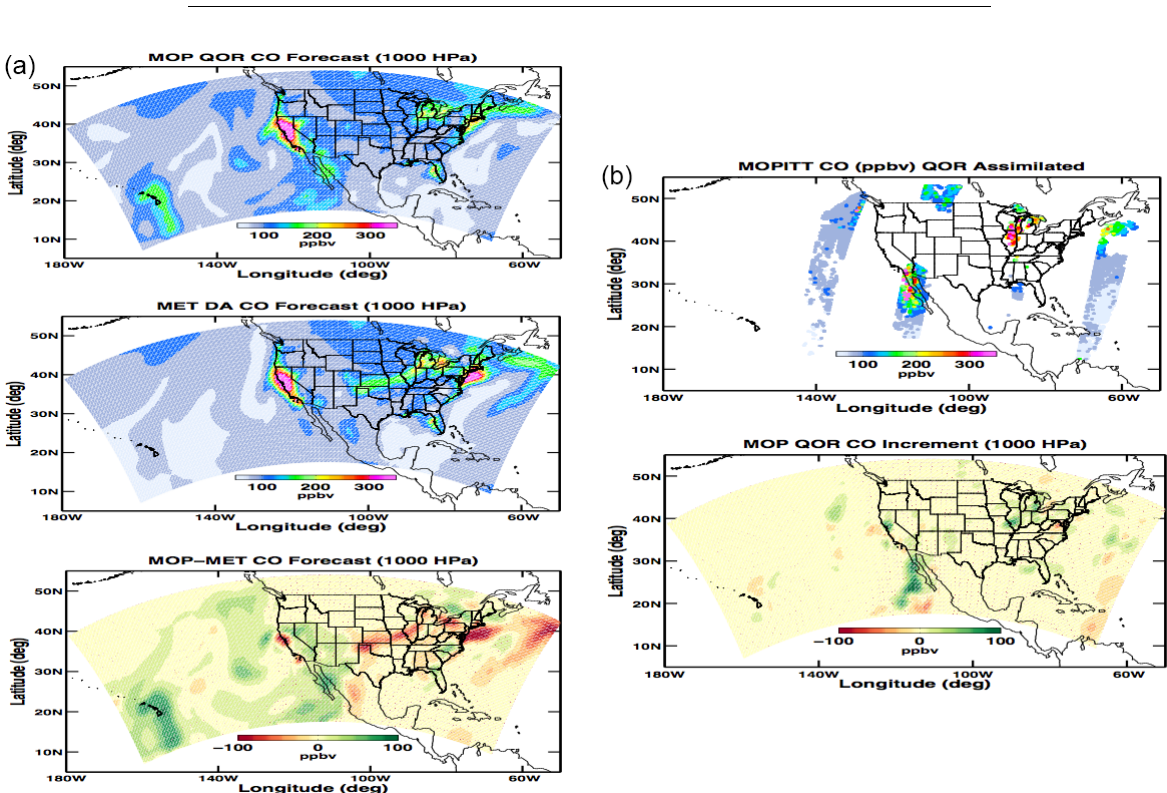
Figure 1. (a) Shaded contours of CO in ppb for the MOP QOR (upper panel) and MET DA (middle panel) experiments for the first model level above the surface ( ∼ 1000hPa) from the 6h forecast valid on 18:00UTC, 28 June 2008. The lower panel shows the difference contours for those experiments (MOP QOR – MET DA). The shaded area represents the WRF-Chem domain. (b) The upper panel shows the assimilated MOPITT CO retrievals between the surface and 900hPa for 18:00UTC, 28 June 2008. The lower panel shows the associated assimilation